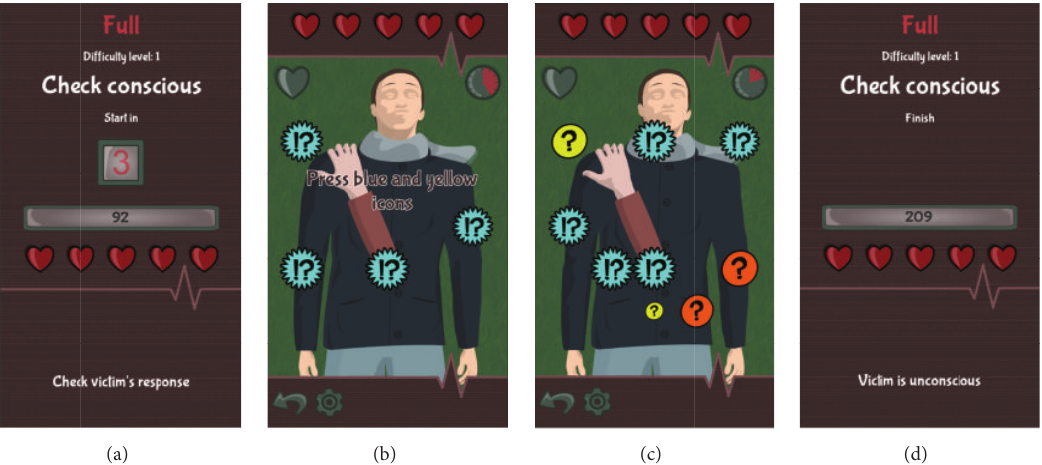
Figure 5: Screens of the Check Conscious mini game. (a) Init screen with game instructions. (b) and (c) scenes with the icons that have to be pressed to shake shoulder, only blue and yellow icons add points. (d) Final screen with the game score and the message that the victim is